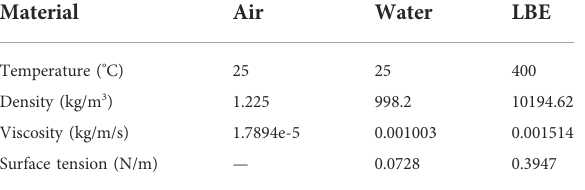
TABLE 1 Material